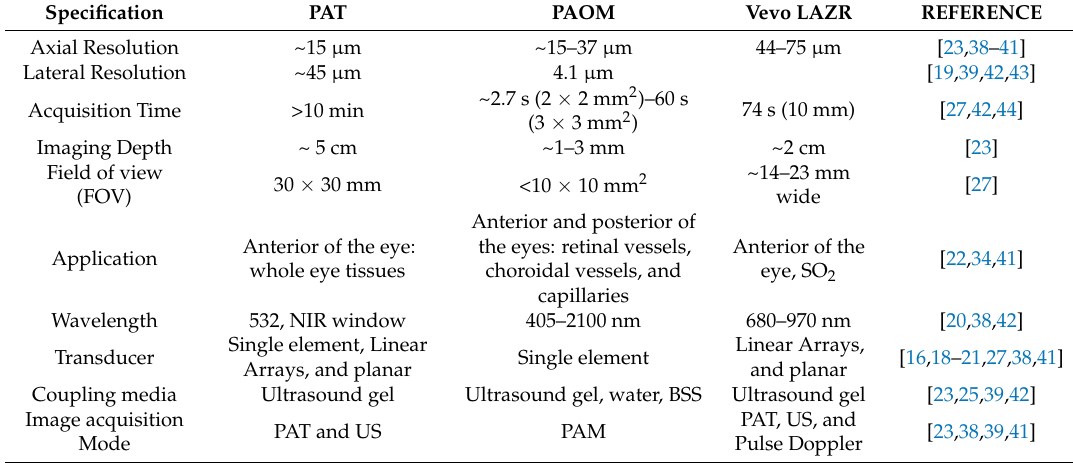
Table 1. Comparisons of current PA imaging modalities of the eye. NIR: near infrared, PAM: photoacoustic microscopy, PAOM: photoacoustic